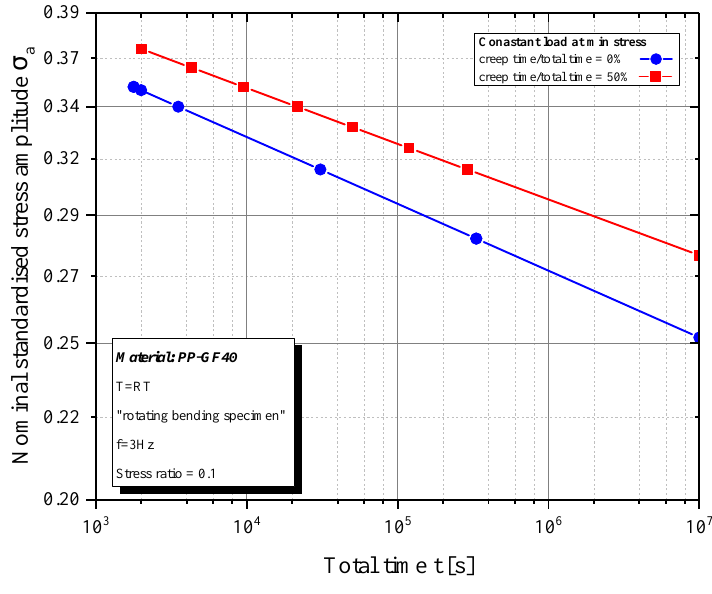
Figure 6. Time to failure for constant load at minimum stress.